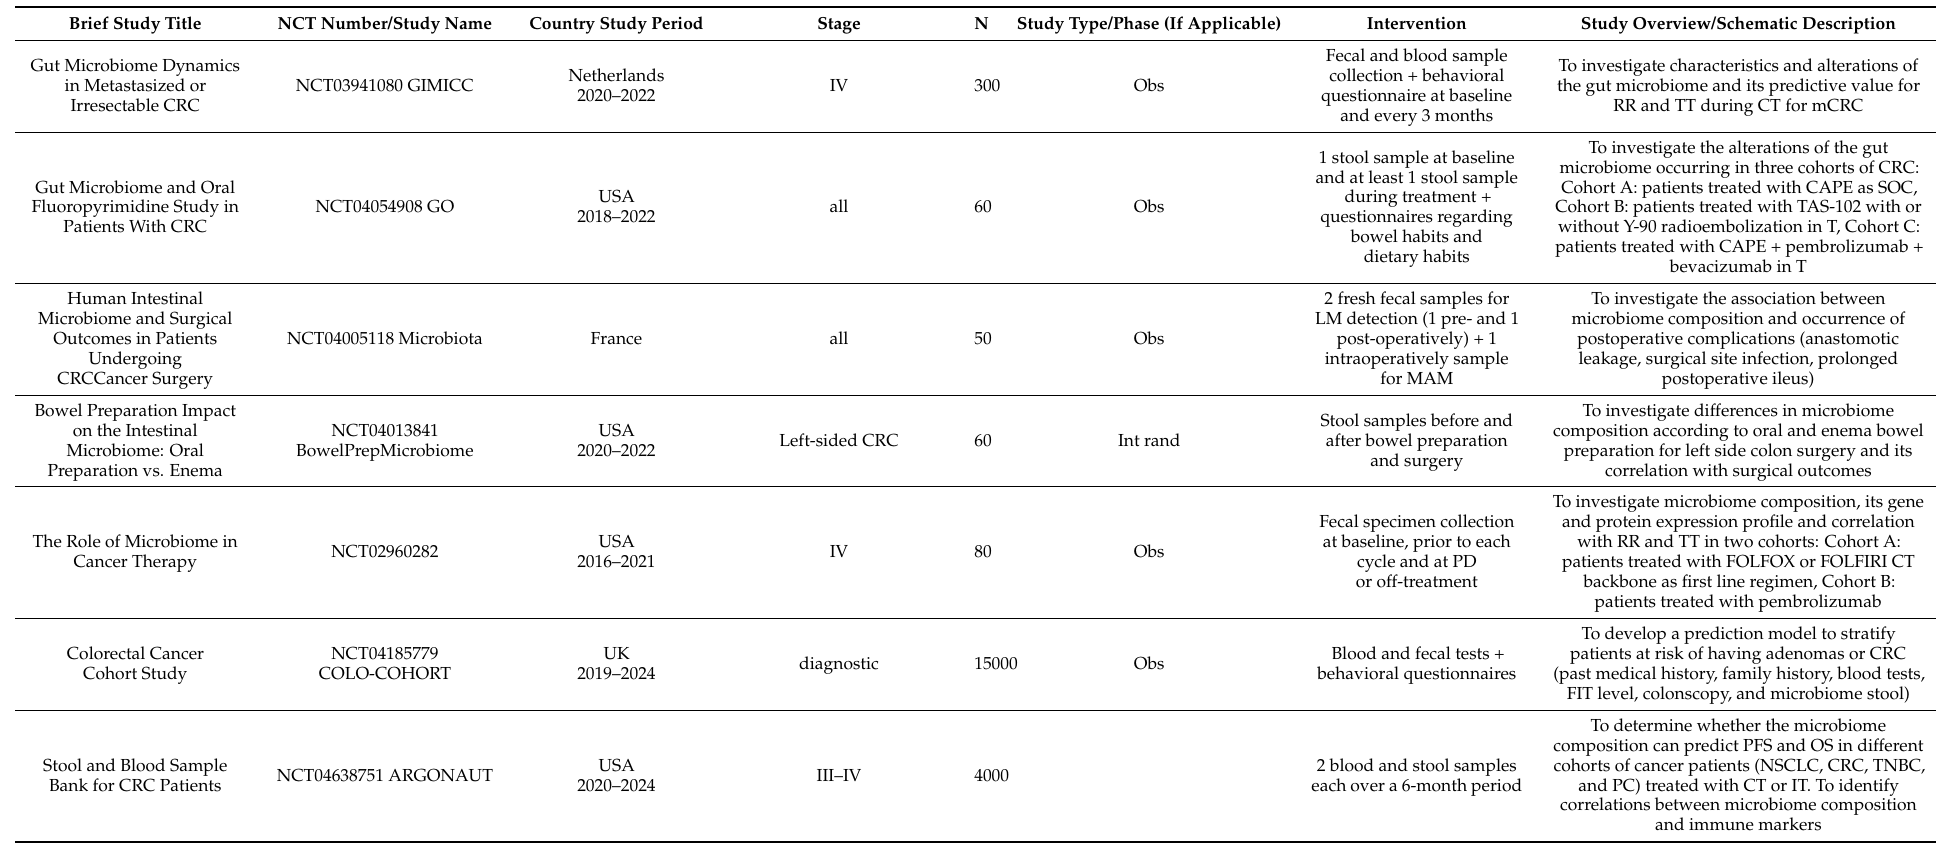
Table 2. List of major ongoing prospective trials investigating the role of microbiota in colorectal